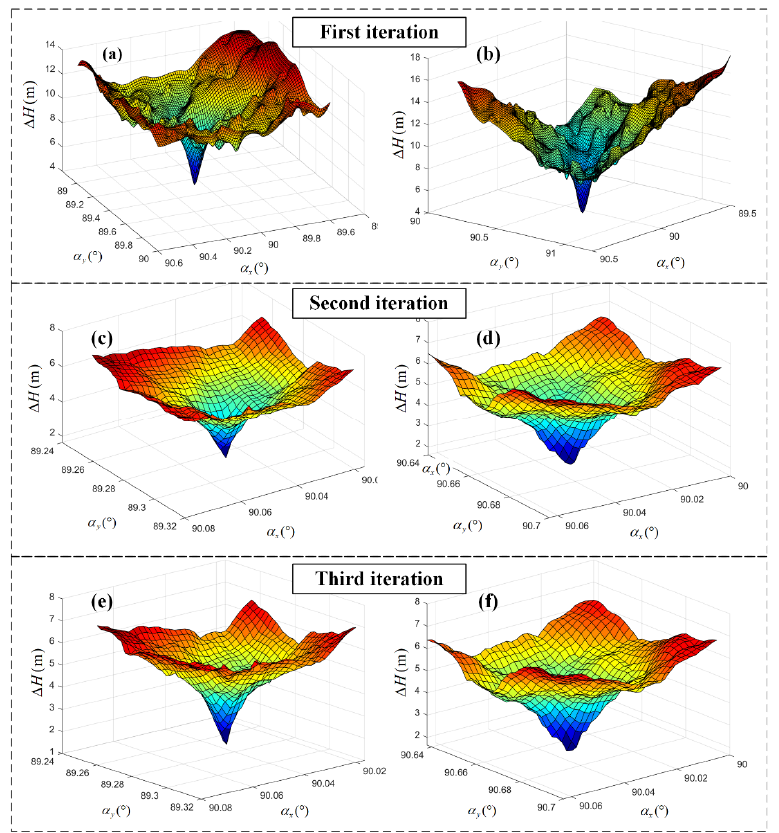
Figure 7. The laser grid pointing angle and the sum of elevation residual plots after calibration based on AW3D30 DSM. ( a , b ) are the experimental results of beams 1 and 2 after the first iteration, respectively. ( c , d ) are the experimental results of beams 1 and 2 after the second iteration, respectively. ( e , f ) are the experimental results of beams 1 and 2 after the third iteration, respectively.